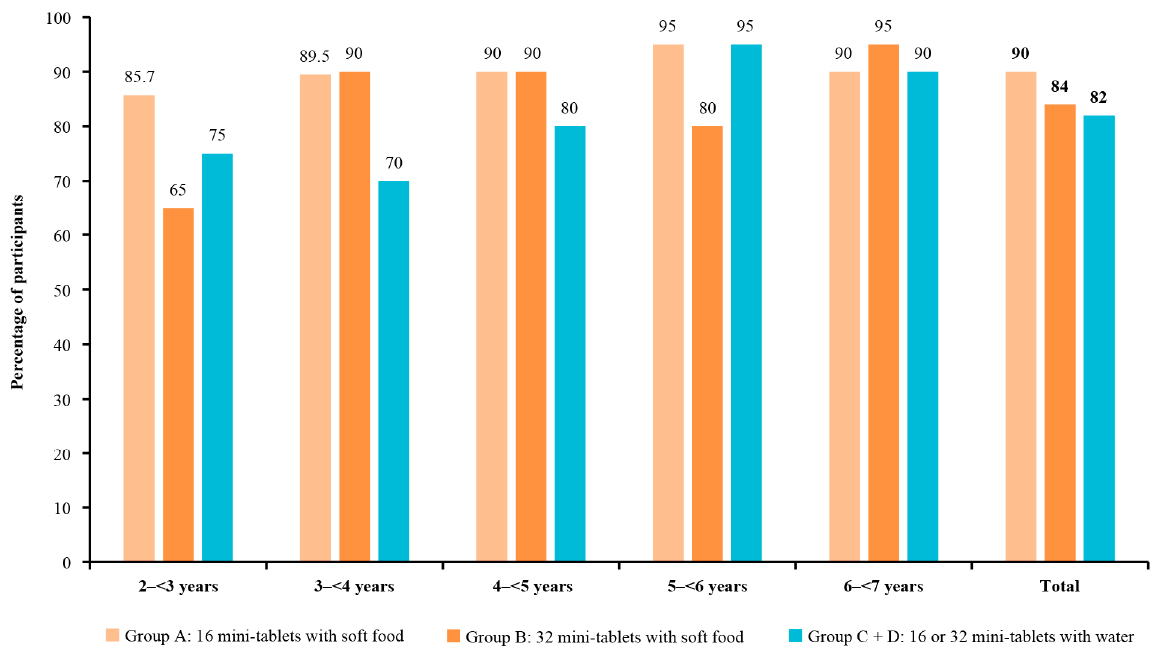
Figure 6. Palatability of 3 mm placebo mini-tablets by age group. For the assessment of palatability, the immediate reactions of the child after the administration of the mini-tablets were recorded as positive (pleasant), neutral (no change), or negative (unpleasant) according to the pre-defined criteria. A positive or neutral reaction qualified as palatable.